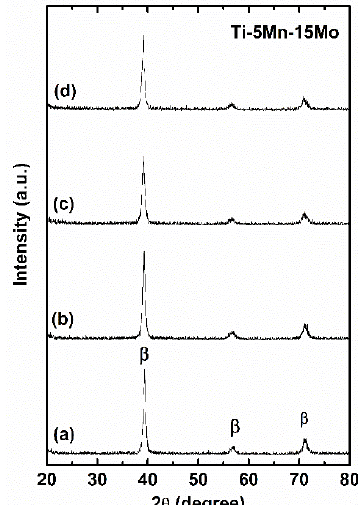
Figure 1. X-ray diffractograms for Ti-5Mn-10Mo alloy after homogenization heat treatment ( a ), after the hot-rolling process ( b ), and after the solution ( c ) and annealing ( d ) heat treatments.